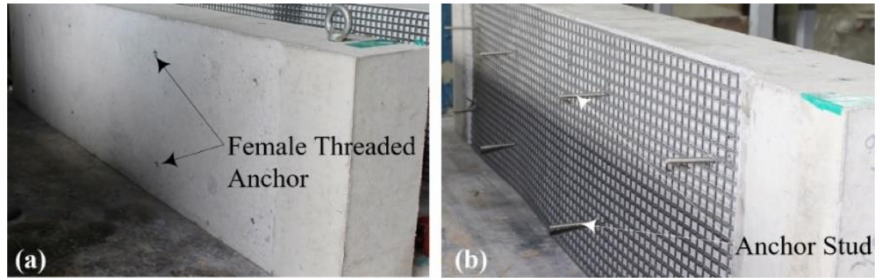
Figure 8. TRC-strengthening process for RC slab: ( a ) grinding and installation of the female-threaded anchor; ( b ) installation of textile grid and male-anchor